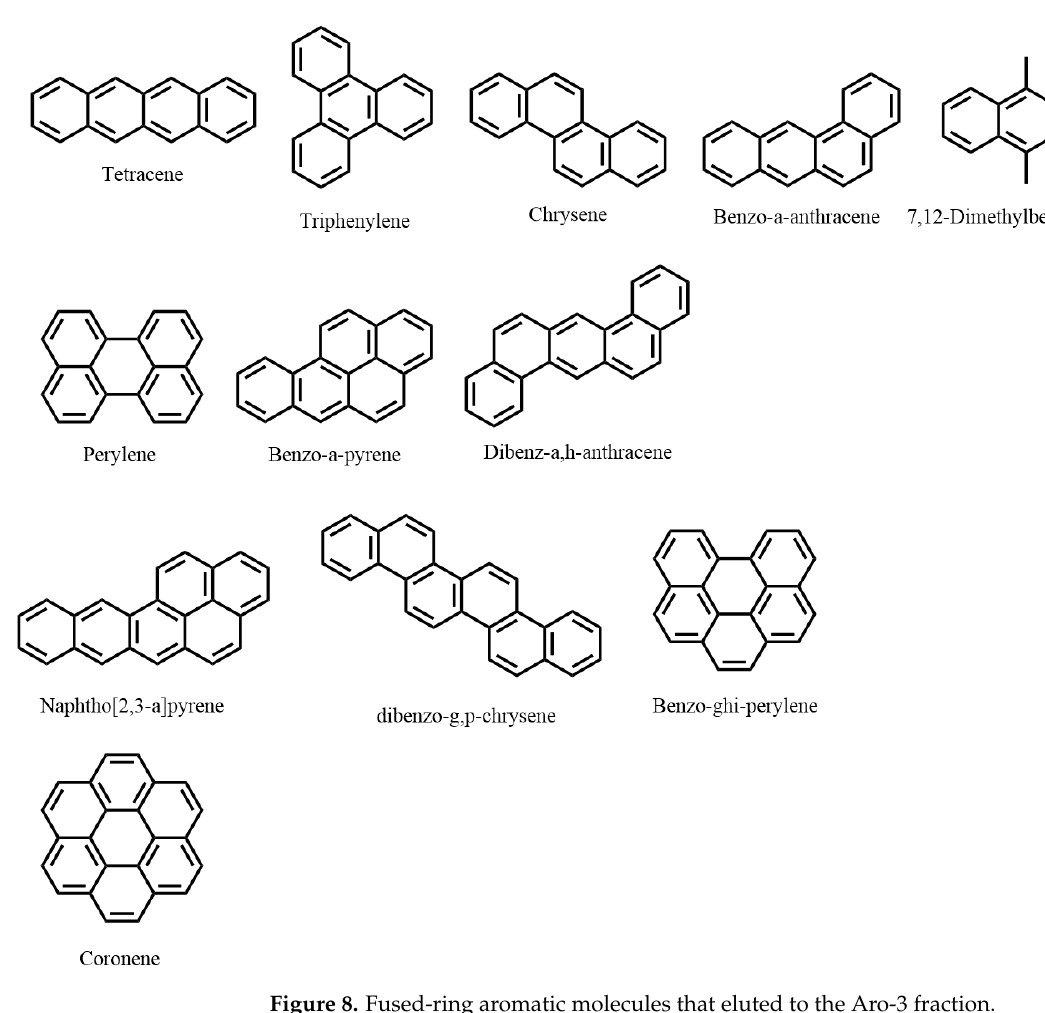
Figure 8. Fused-ring aromatic molecules that eluted to the Aro-3 fraction.